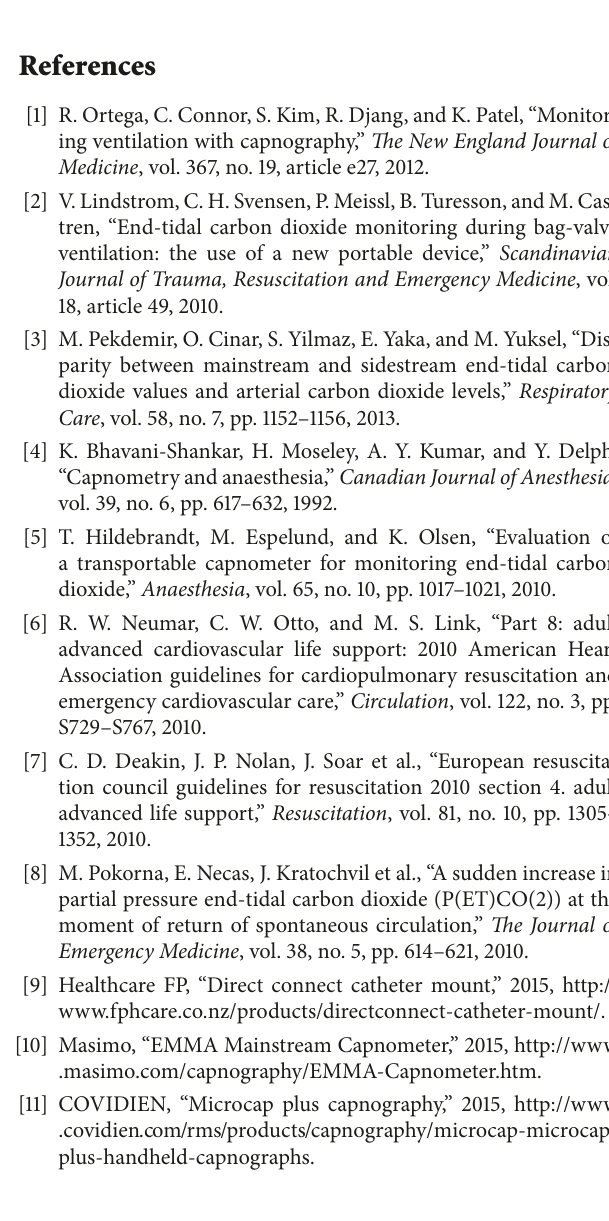
Figure S1. Bland-Altman plots for evaluating agreement of ETCO2 measurement between pDCCM and dDCCM under water exposing conditions (baseline, 5 mL water, 10 mL water). Figure S2. Bland-Altman plots for evalu- ating agreement of ETCO2 measurement between main- stream and microstream capnometer under water expos- ing conditions (baseline, 5 mL water, and 10 mL